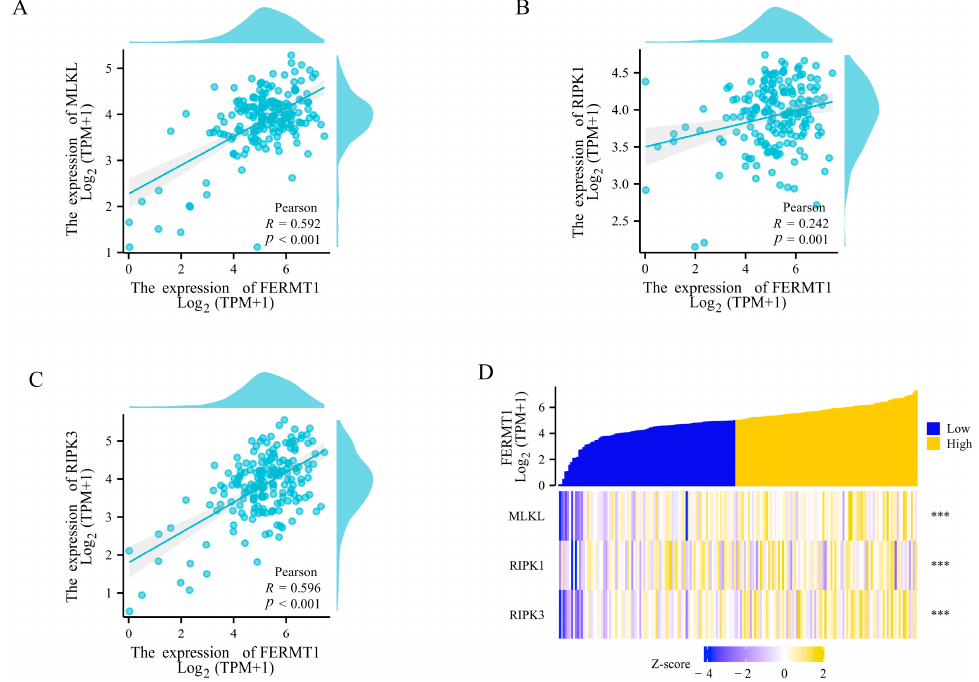
Figure 8. The correlation between FERMT1 expression and necroptosis-driving genes in PAAD. ( A ) MLKL, ( B ) RIPK1, ( C ) RIPK3, ( D ) Expression differences of necroptosis-driving genes in the low and high FERMT1 expression groups. *** p < 0.001.